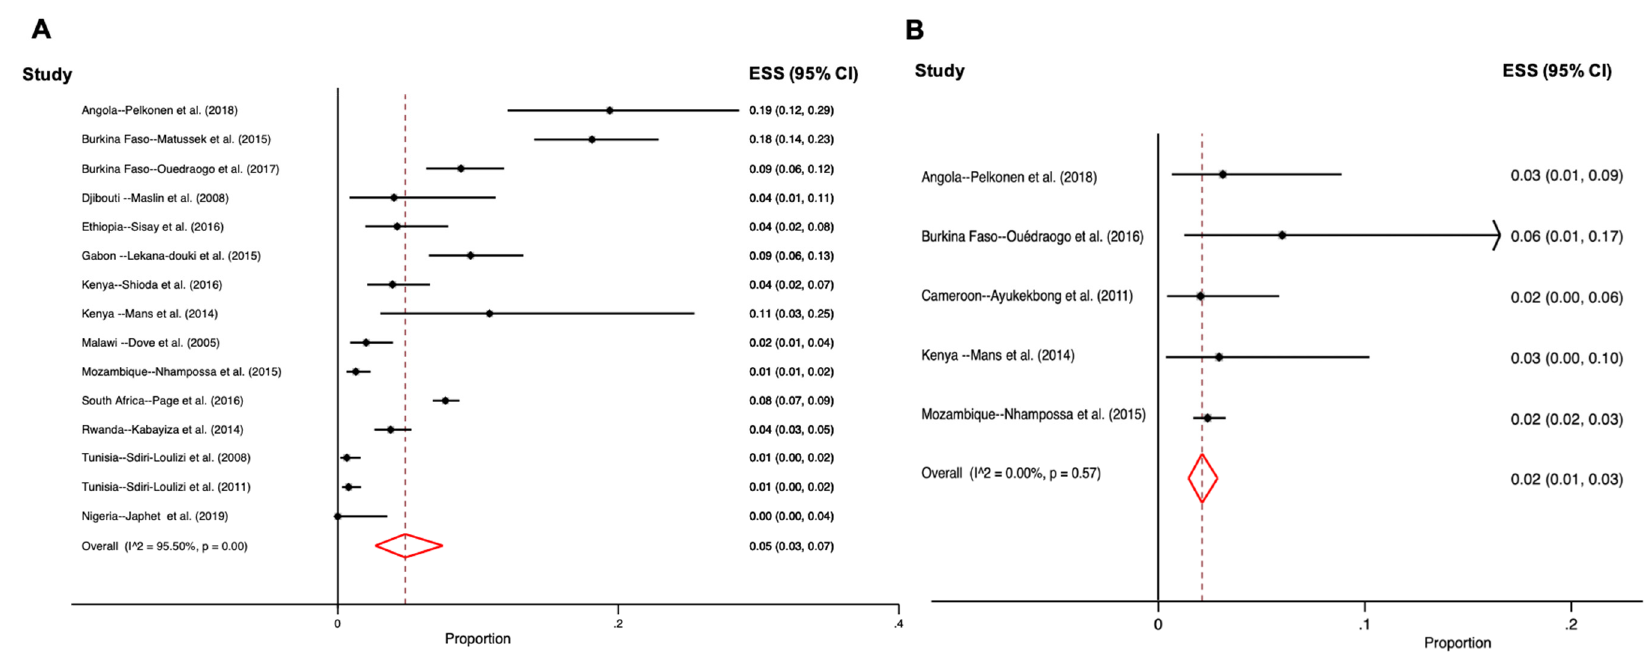
Figure 3. Forest plots for meta-analysis of sapovirus prevalence among ( A ) symptomatic, ( B ) asymptomatic individuals. (ESS – estimated effect size or proportion of cases; I 2 – heterogeneity statistic; CI – confidence interval).